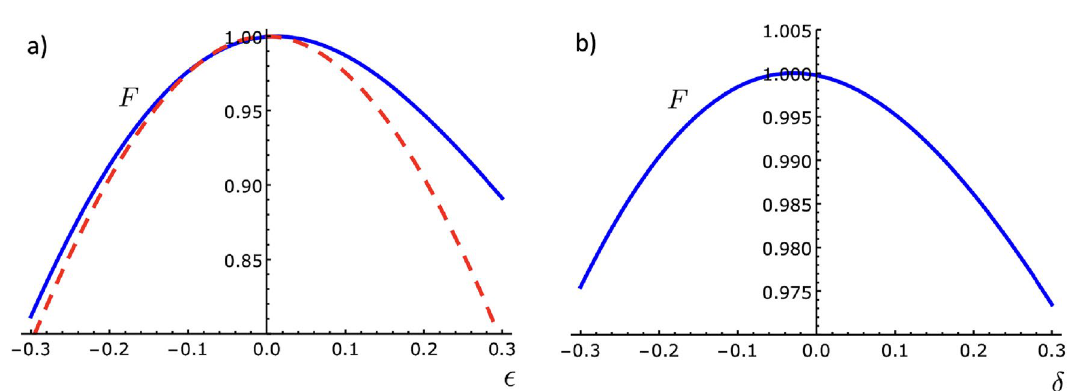
Figure 3. Time evolution of the populations for the TR passage protocol with the initial state given by the contraction parameter assuming the values ( a ) a population inversion occurs at least a times faster than in the reference ( a parameters as in Fig. 1.